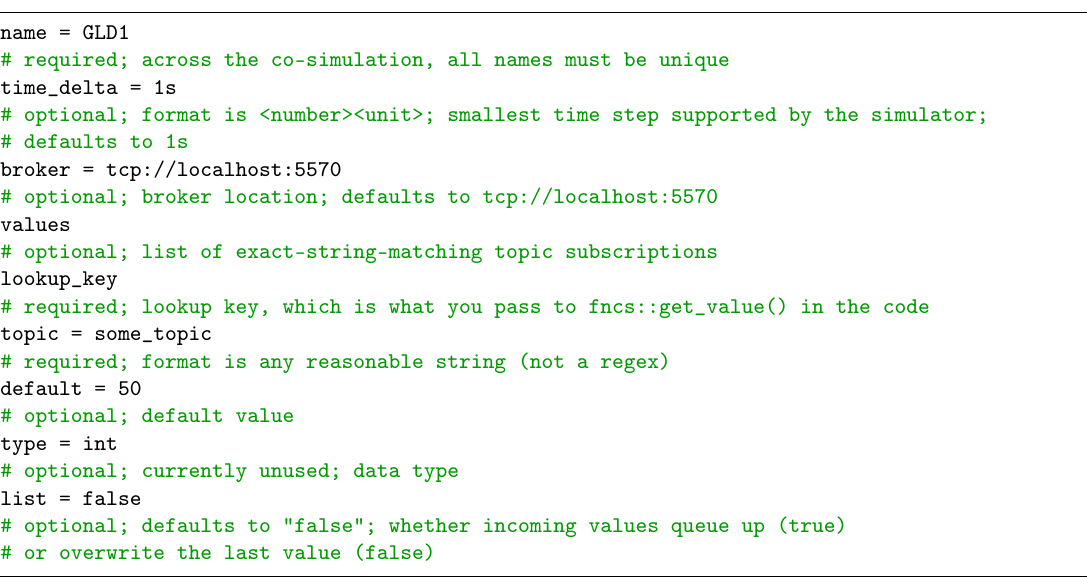
Figure 2. An example of the fncs.zpl